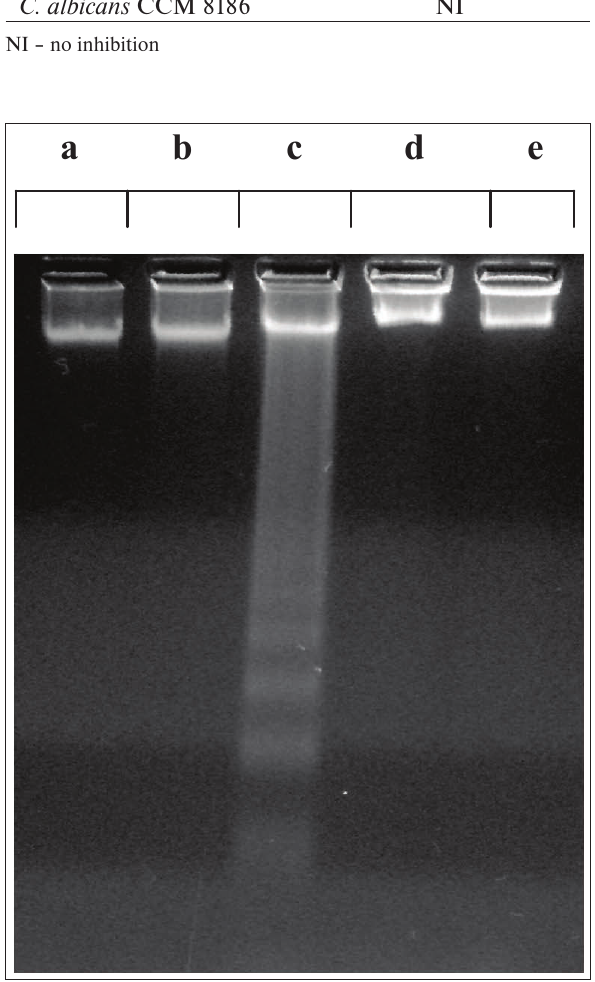
Fig. 5. Coladerm-beta glucan membrane effect on the level of DNA damage in VH10 and B-HNF-1 cells after 24 h of treat- ment. Cells growing without the membrane were used as a nega- tive kontrol, P <0.05 was considered statistically